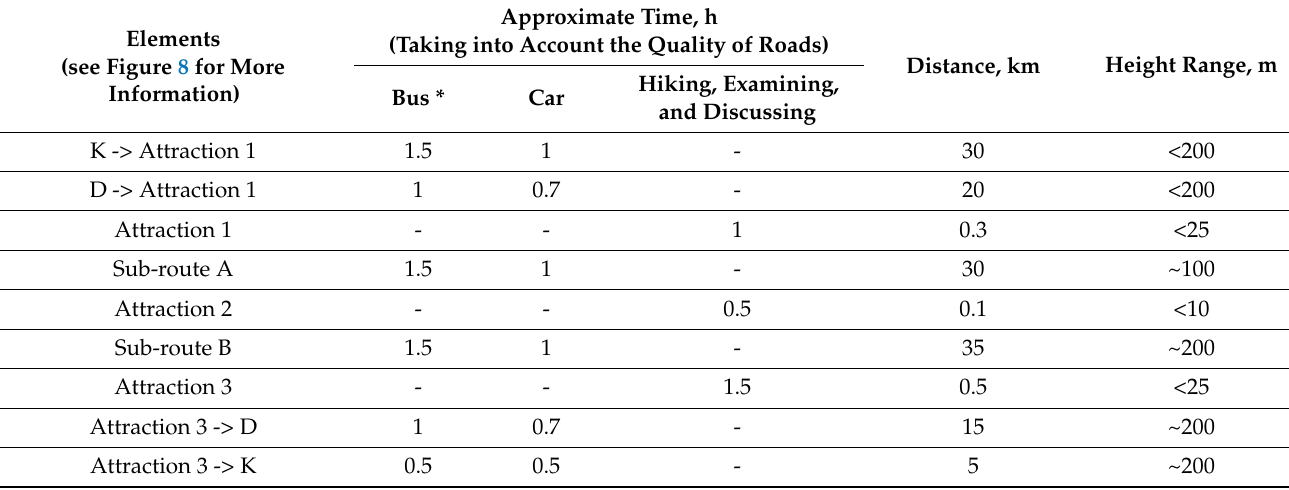
Table 2. Parameters of the proposed